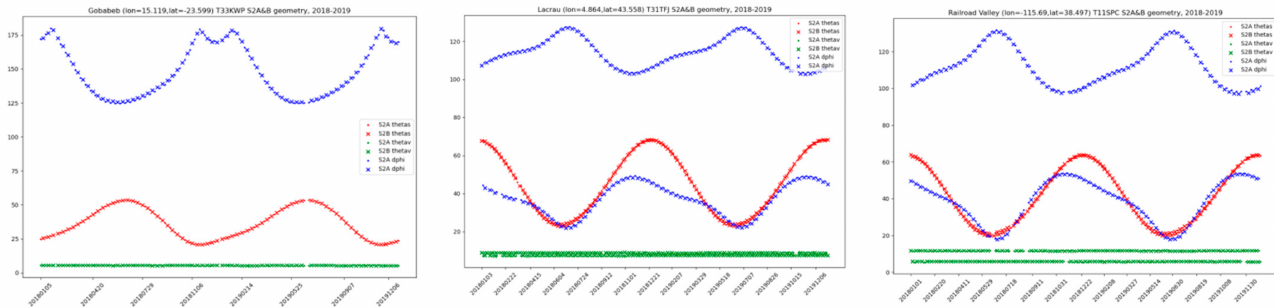
Figure 1. Geometry of acquisition for the S2A&B at the three selected RadCalNet sites. Left, Gobabeb is observed only on the orbit 107. Middle, La Crau is observed on both orbits 8 and 108. Right, Railroad Valley is observed on orbits 27 and